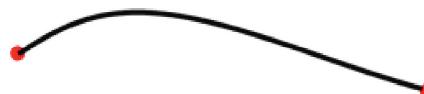
Figure 18: Implicit surface.